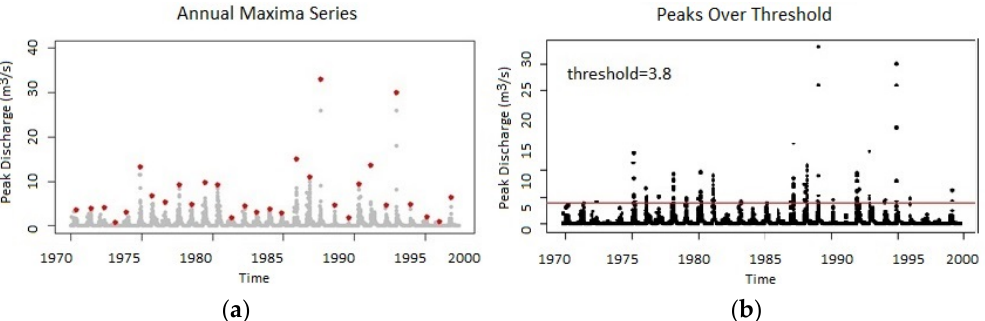
Figure 1. ( a ) Peak Discharges for Annual Maxima Series (AMS) method, ( b ) Peak Discharges for Peaks over Threshold (POT)